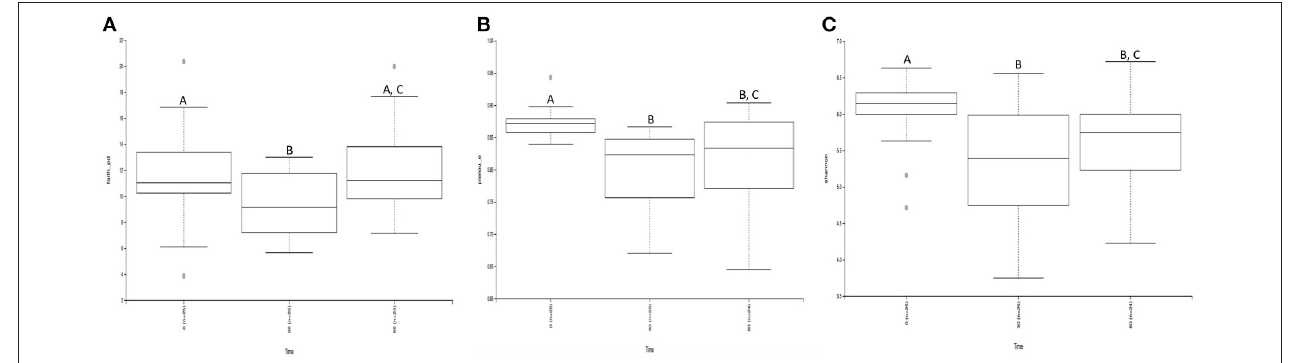
FIGURE 3 | Alpha diversity significance by time throughout the course of sanitation (A) Faith’s diversity index; (B) Pielou’s evenness index; (C) Shannon diversity index. When comparing pairwise differences, the same letter within graph is not significantly different whereas different letters are statistically significantly different ( Q < 0.05). Overall, diversity deceases with time. TABLE 1 | Significant Kruskall-Wallis pairwise differences in alpha diversity indices whose main effects were significant. Kruskall-Wallis pairwise